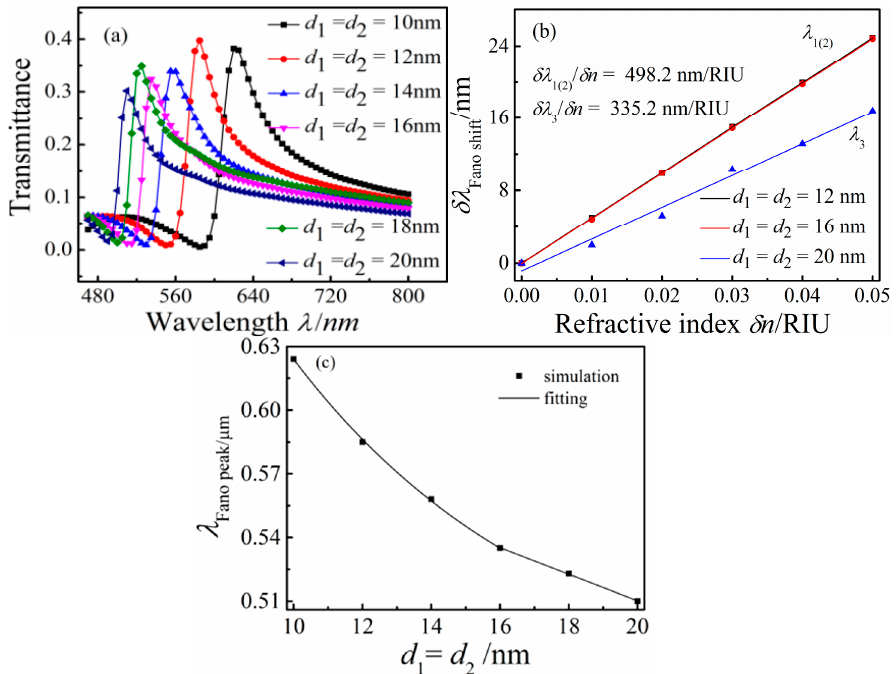
Figure 5. ( a ) Transmission spectra for different rectangular cavity widths d 1 ( d 2 ); ( b ) the shift of the Fano resonance peak as a function of the refractive index change δ n ; and ( c ) the Fano resonance peak as a function of the rectangular cavity widths change d 1 ( d 2 ).